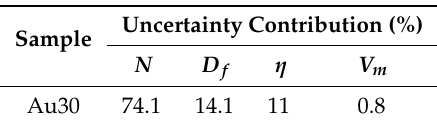
Table 4. Relative uncertainty contributions for single particle inductively coupled plasma mass spectrometry (spICPMS) for the Au30